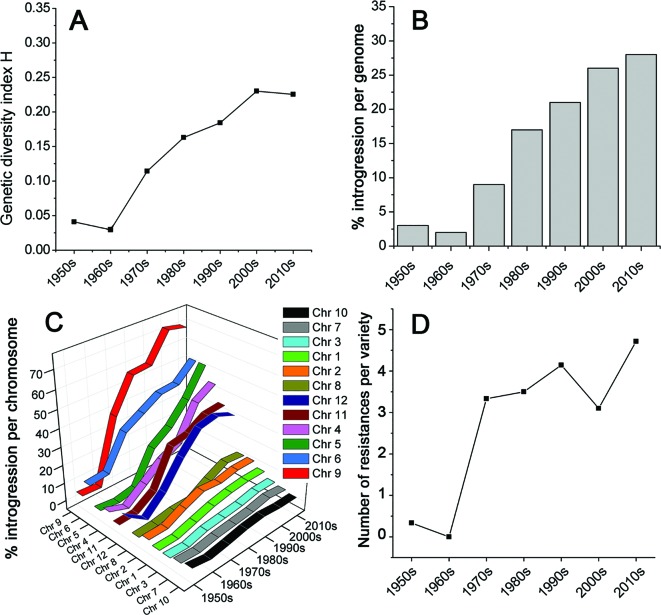
Genetic diversity of tomato varieties, commercially introduced from 1950 till 2016. (A) The diversity within a decade is expressed as Nei’s index, also referred to as expected heterozygosity. (B) The proportion of the genome and (C) individual chromosomes of commercial tomato varieties, consisting of introgressions compared to the prevailing genome of tomato varieties in the 1950s and 1960s. (D) Average number of diseases and pest to which the investigated varieties are resistant, according to the official NAKTuinbouw variety database [https://www.naktuinbouw.com/groente/variety-description/tomato-solanum-lycopersicum-l; (Banga and Aalbersberg, 1995)].